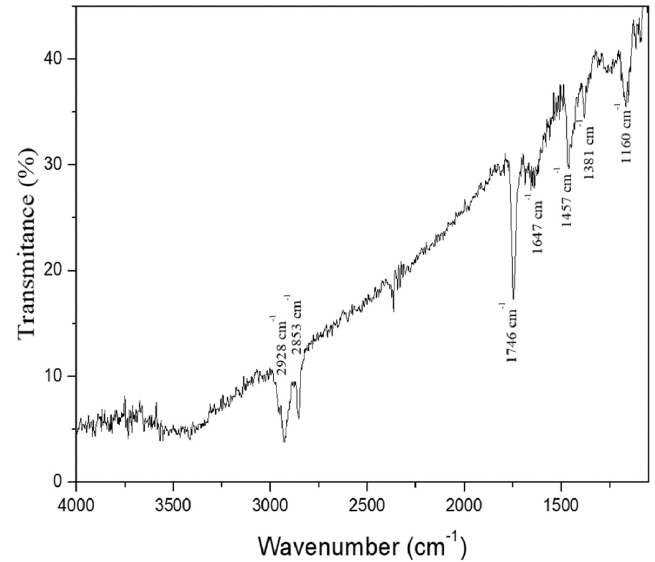
Figure 2. Fourier transform infrared spectrum (FTIR) of the n-hexane extract of Desmodesmus sp.